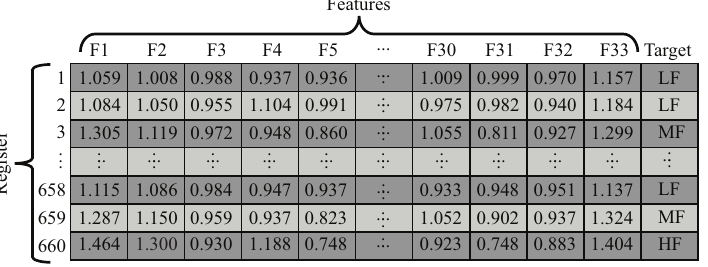
Figure 10. Data set representation composed of 660 STS registers, 33 features and the fatigue